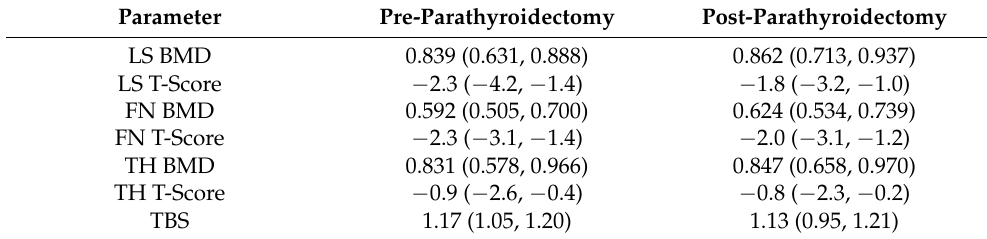
Table 4. Comparison of BMD and TBS pre- and